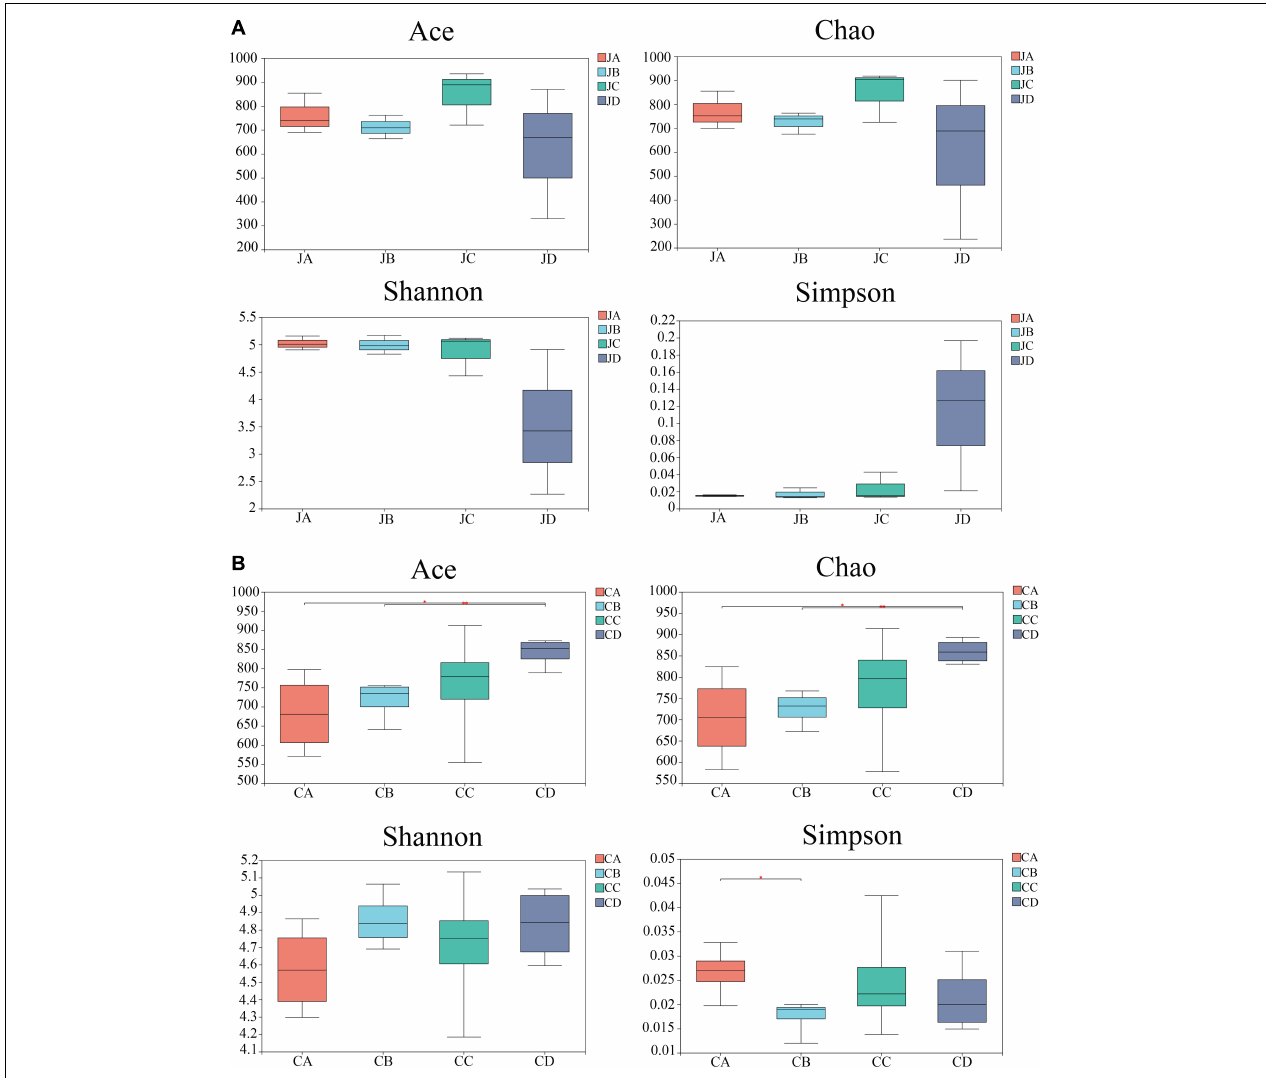
FIGURE 3 | Alpha diversity of four groups in jejunum (A) and cecum (B) . Significant difference between samples and marks with significant differences between two groups. JA, jejunum of 0% HILM; JB, jejunum of 1% HILM; JC, jejunum of 3% HILM, JD: jejunum of 5% HILM; CA, cecum of 0% HILM; CB, cecum of 1% HILM; CC, cecum of 3% HILM; CD, cecum of 5%